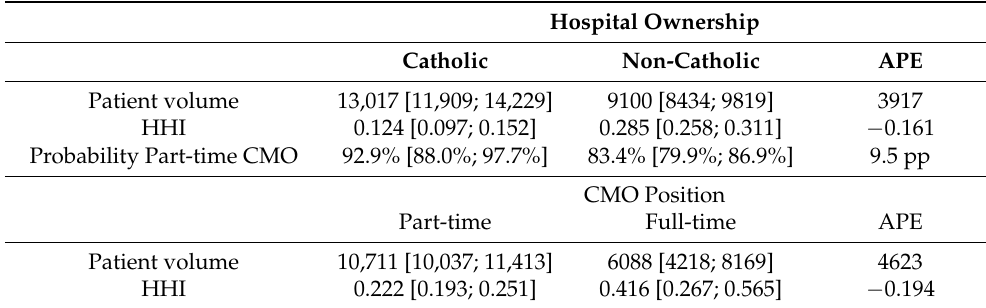
Table 3. Predictions including 95% CI and average partial effects derived from Model